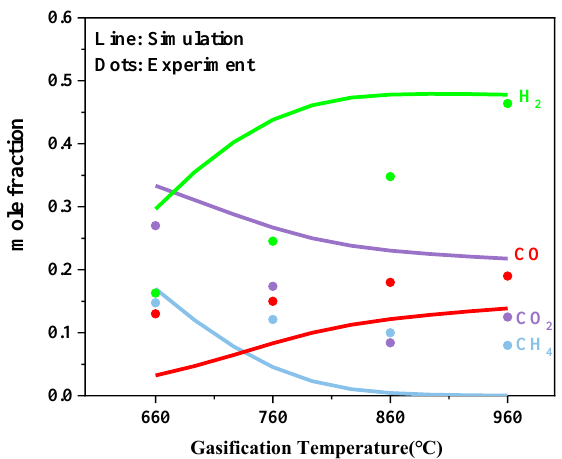
Figure 14. Effect of gasification temperature on gas distribution for the raw syngas.